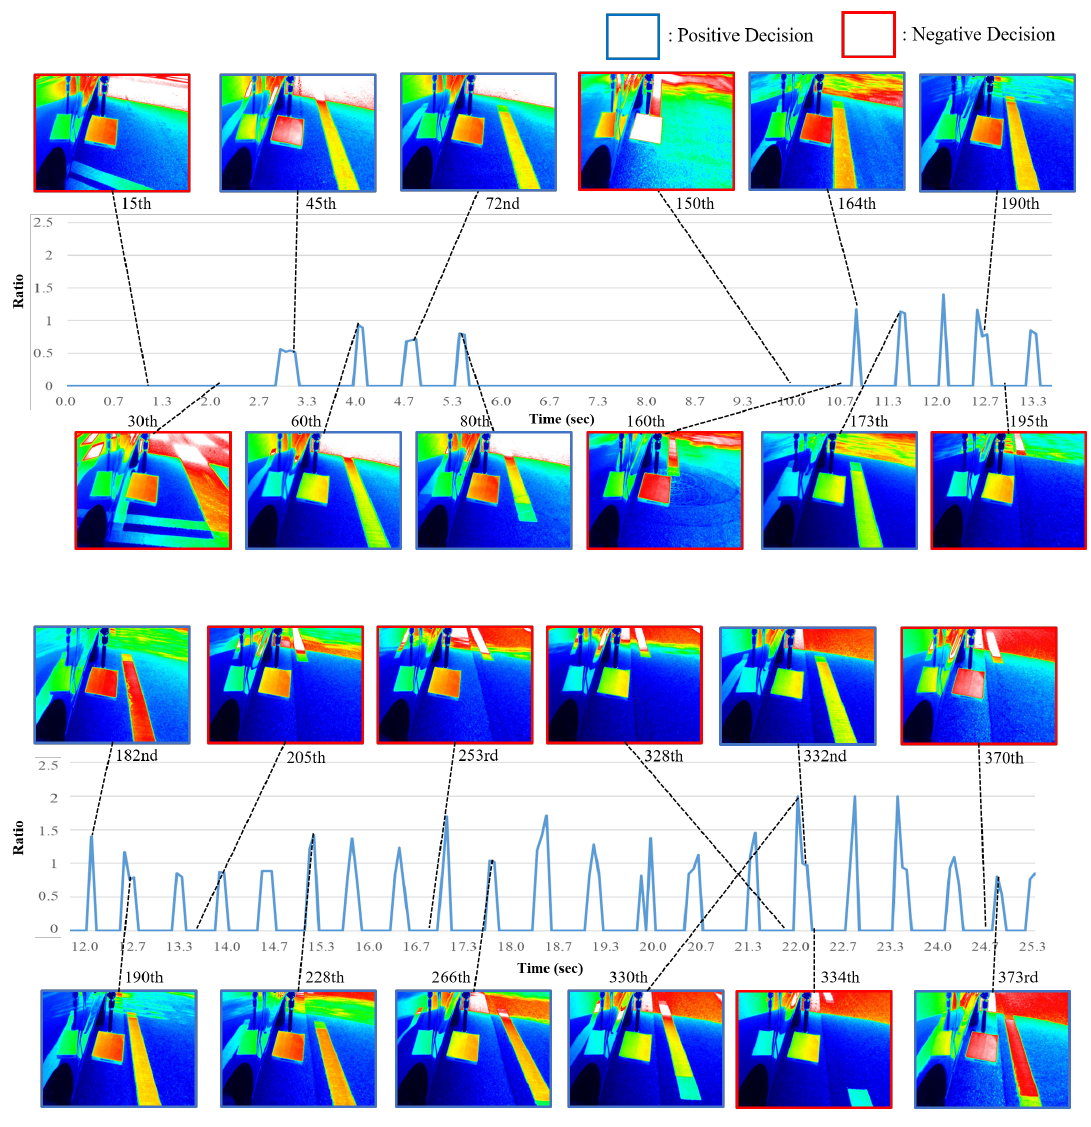
Figure 10. Predicted dynamic retroreflection